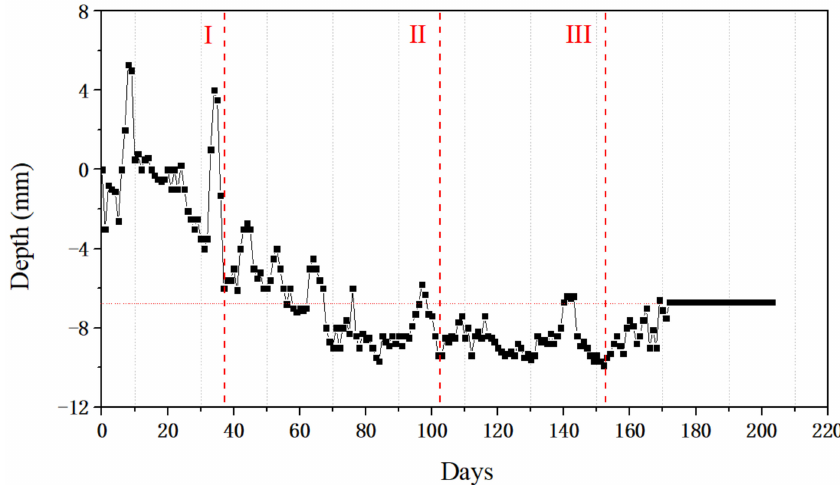
Figure 4. Groundwater level with